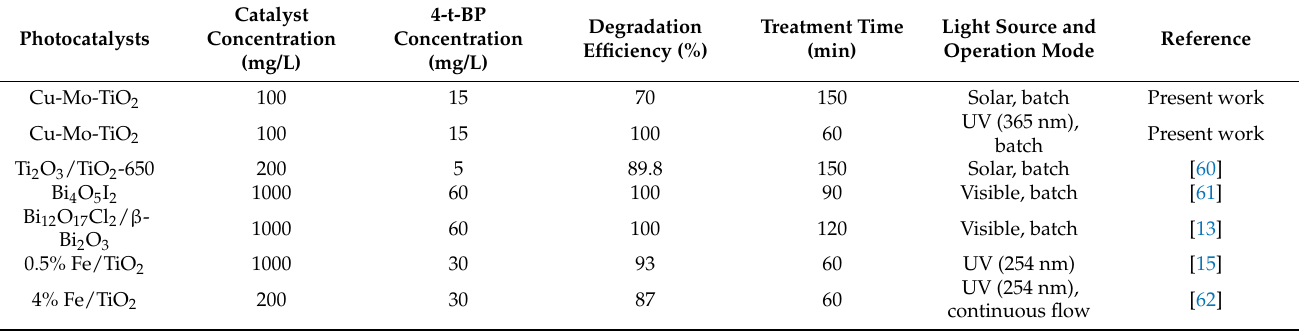
Table 2. Photocatalytic degradation of 4-t-BP by different